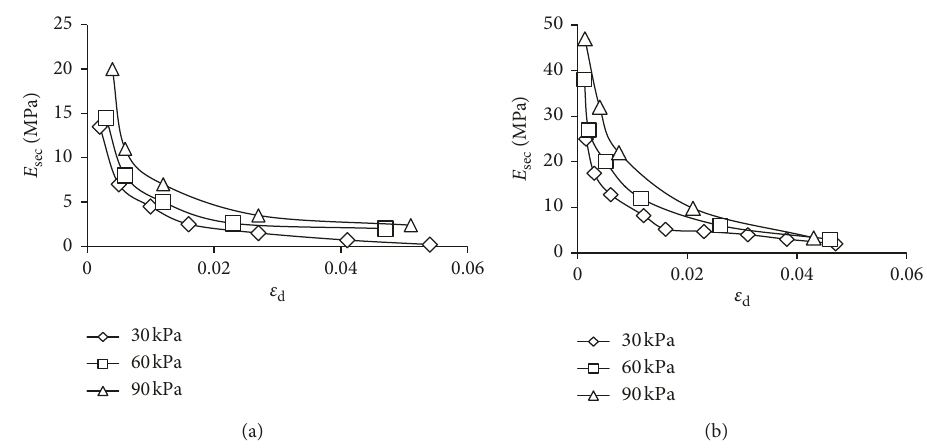
∼ ε sec d under different confining pressures. (a) T13; (b) T31.